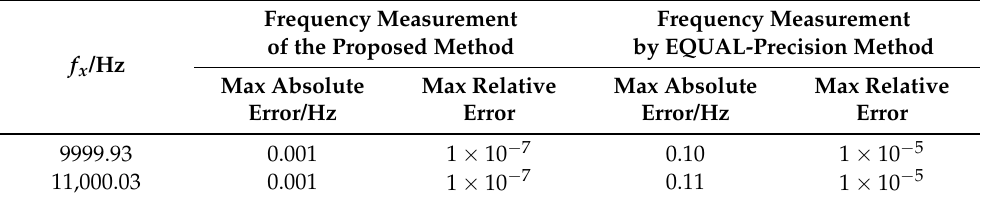
Table 2. Simulated error table under the gate time of 1 s.